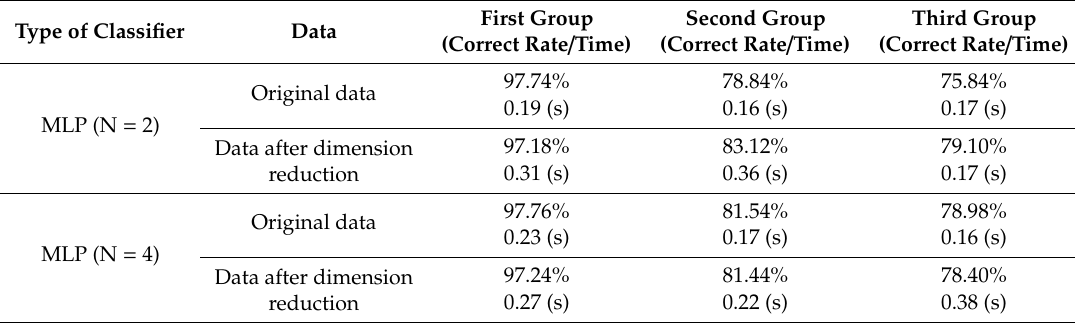
Table 5. MLP training and detection